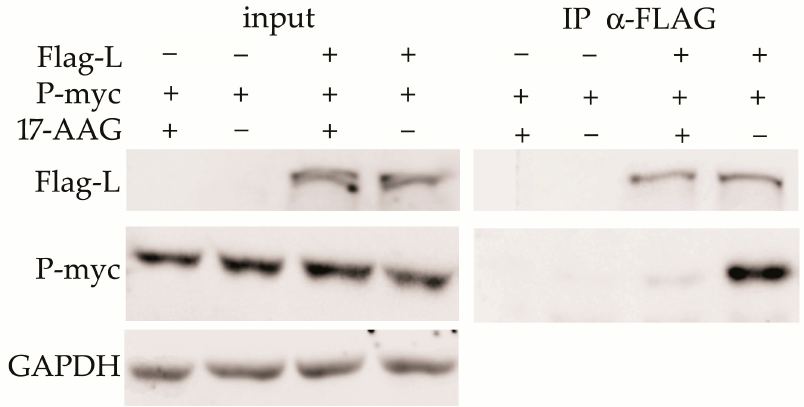
Figure 4. Hsp90 facilitates L–P complex formation. HEK293 cells were transfected with the P-myc and Flag-L plasmids as indicated. 17-AAG was added 2 h after transfection and the cells were lysed in IP buffer 24 h later. Agarose-bound α -Flag antibody was used for immunoprecipitation, and anti-Flag and anti-myc antibodies were used to detect precipitated proteins. The results of one of two experiments are presented.